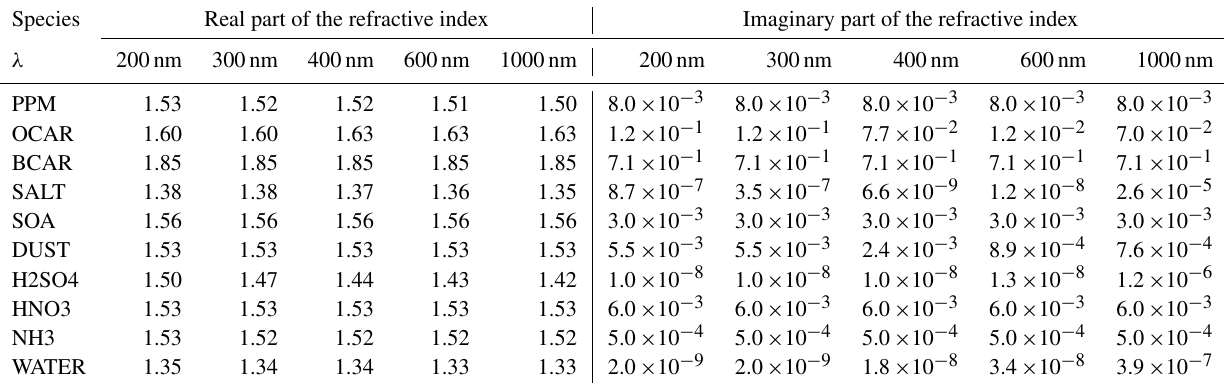
Table 5. Refractive indices for the main aerosol species in CHIMERE at 200, 300, 400, 600 and 1000nm. Species Real part of the refractive index Imaginary part of the refractive index λ